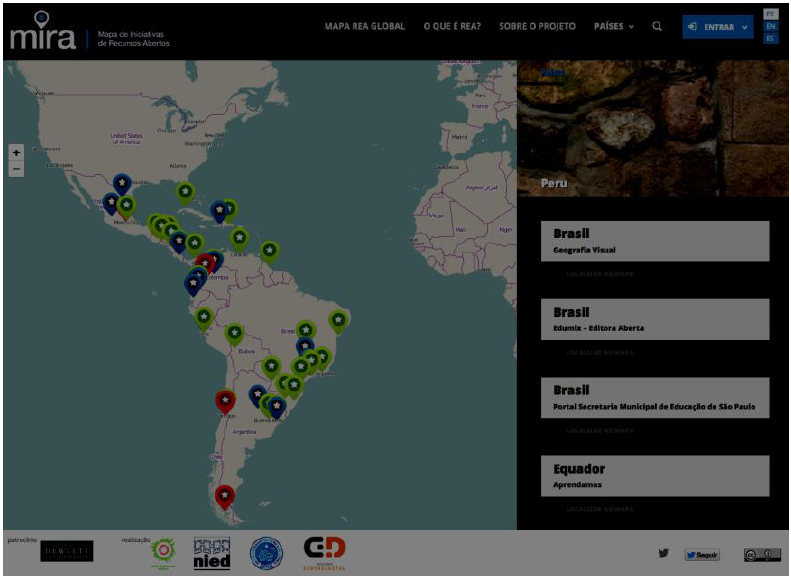
Figure 1. Multilingual MIRA prototype main page at mira.org.br